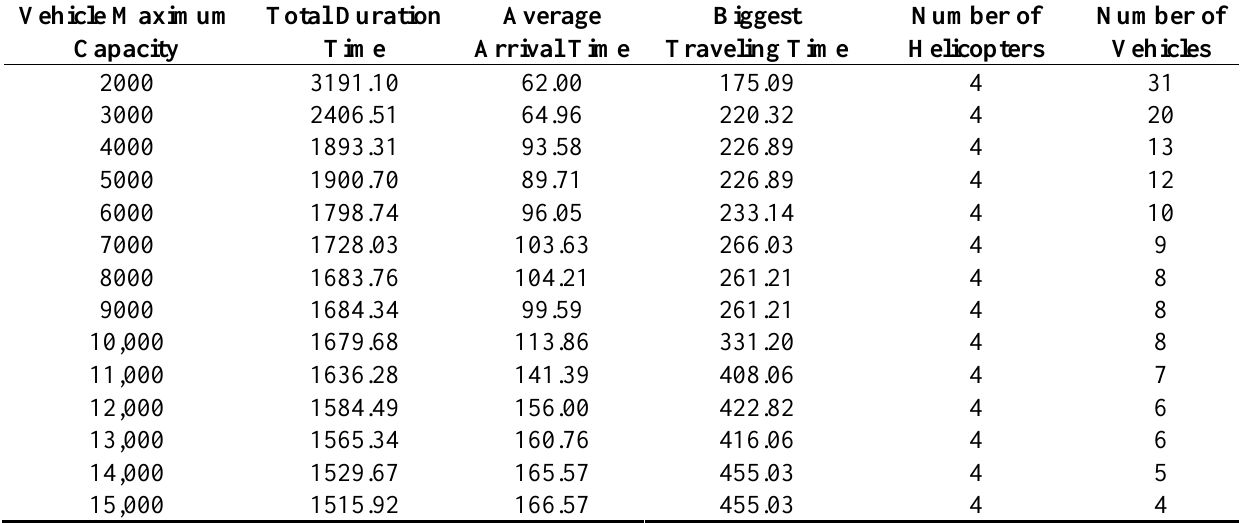
Table 4. Results with four TDCs and different vehicle maximum capacities.